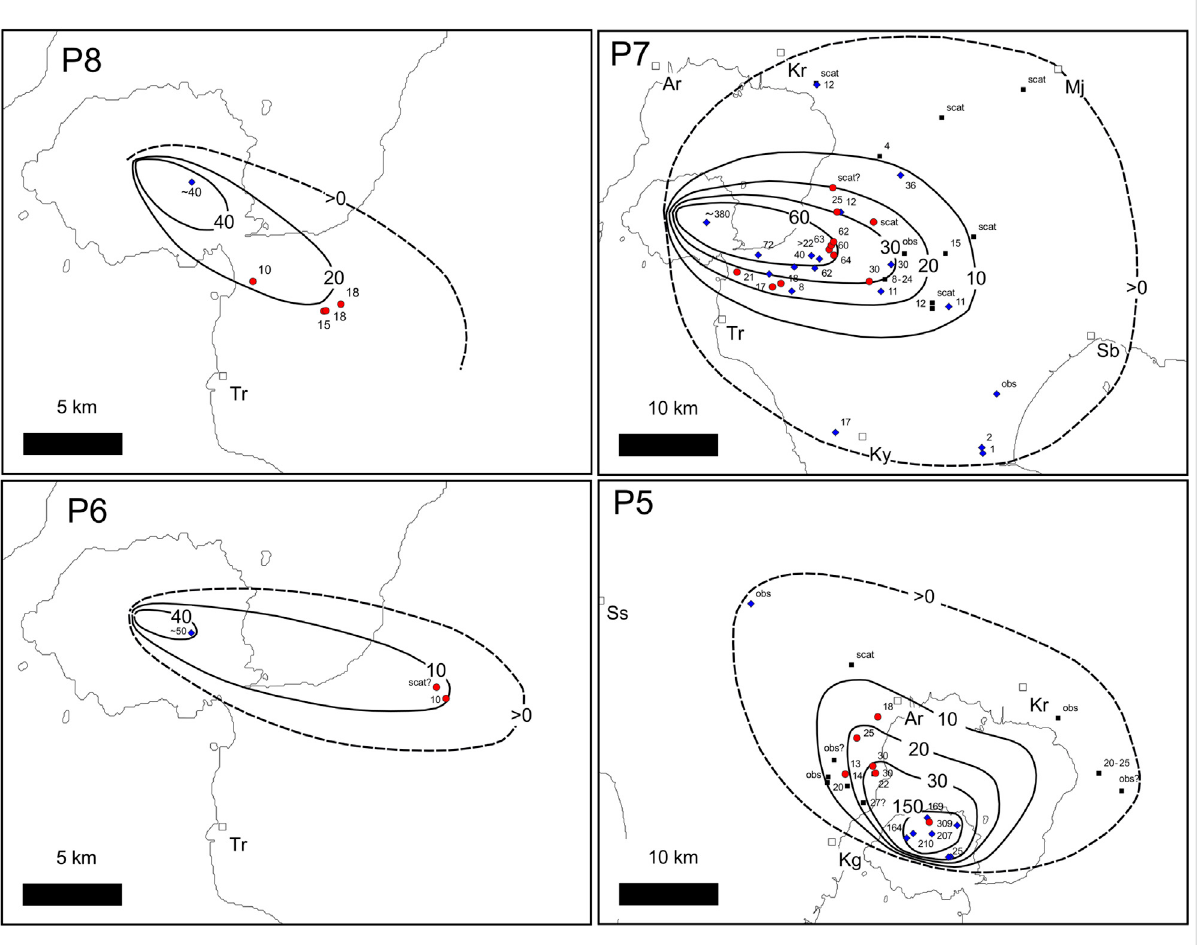
FIGURE 8 Distributions of the P8-P5 pumice fall deposits. Legend is the same in Figure 3A. The numbers of the thickness and isopach contours are